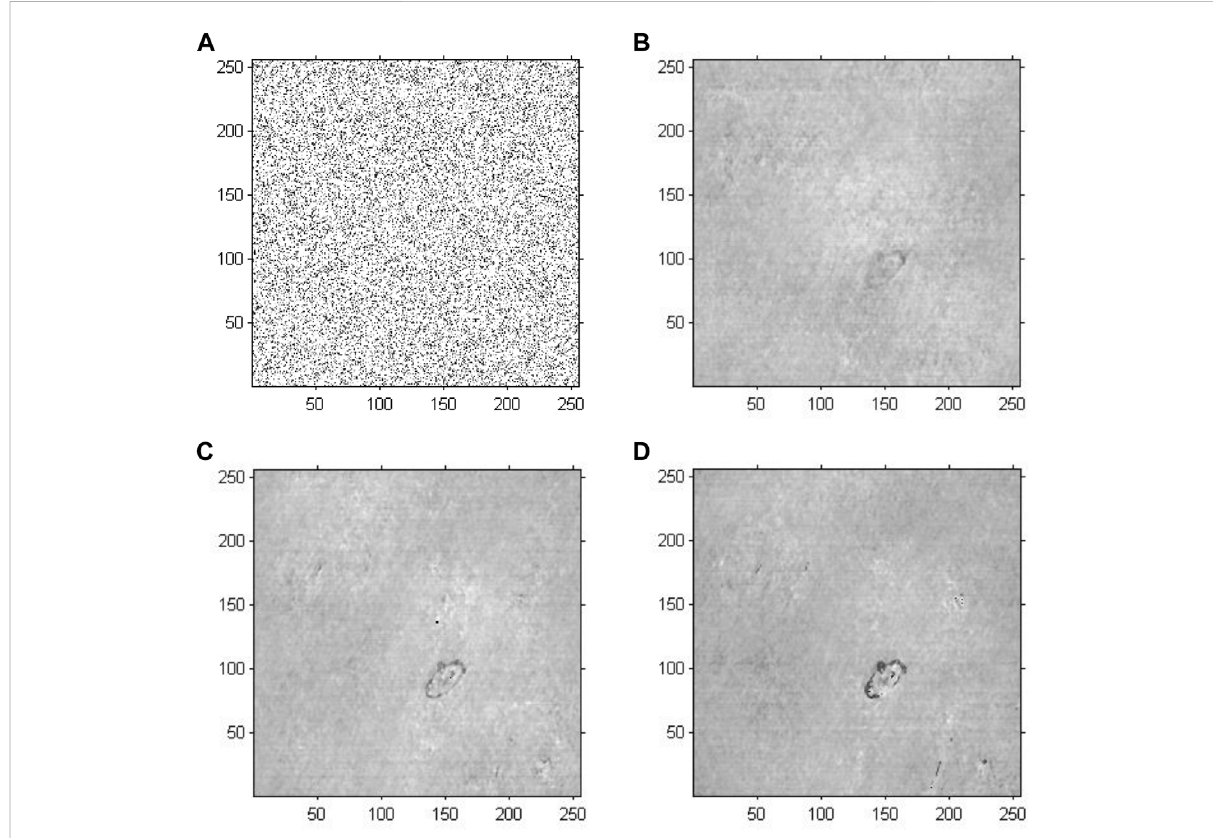
FIGURE 7 Phasereconstruction-basedholographicimageforModel3usingtheimprovedGSalgorithmwiththeoptimalinitialphase. (A) Optimizedinitial phase. (B) Twenty iterative reconstruction images of phase information. (C) 200 iterative reconstruction images of phase information. (D) 2000 iterative reconstruction images of phase